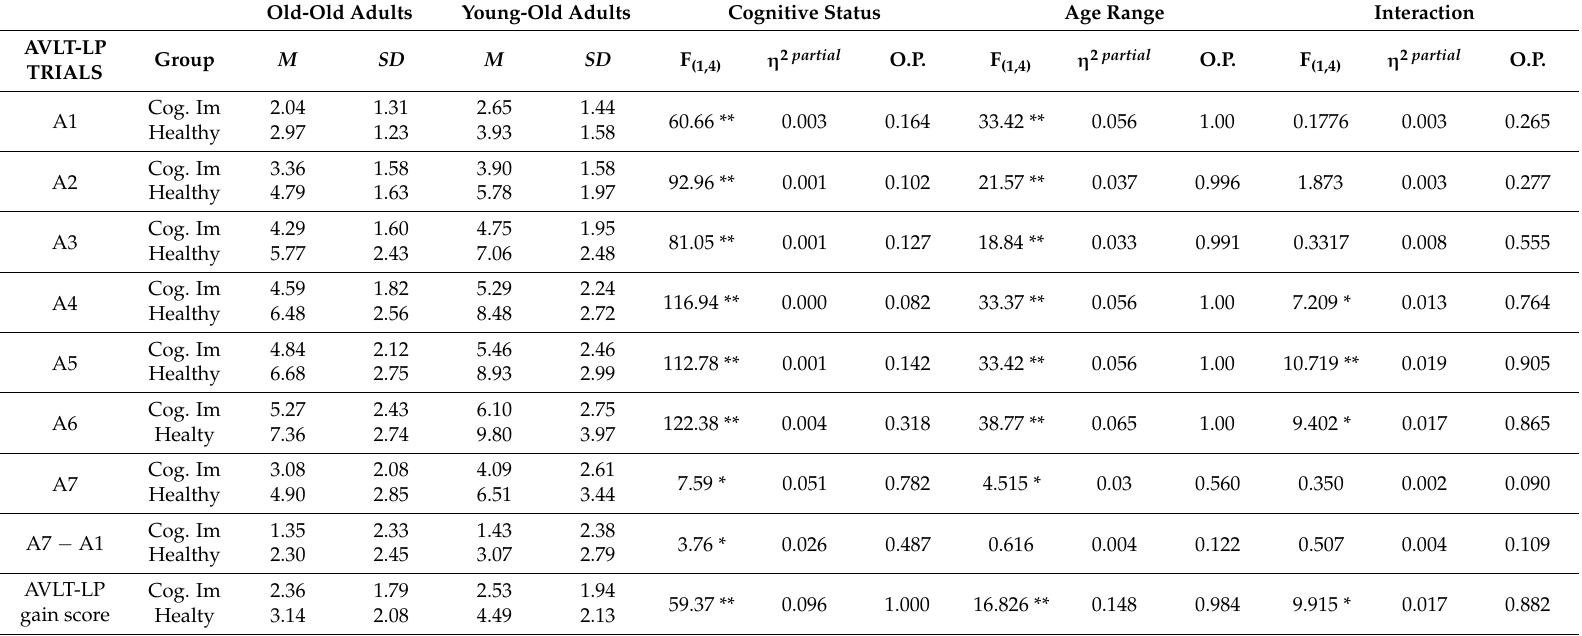
Table 3. Multivariate Analysis of Variance (MANOVA, 2X2 Age range X cognitive